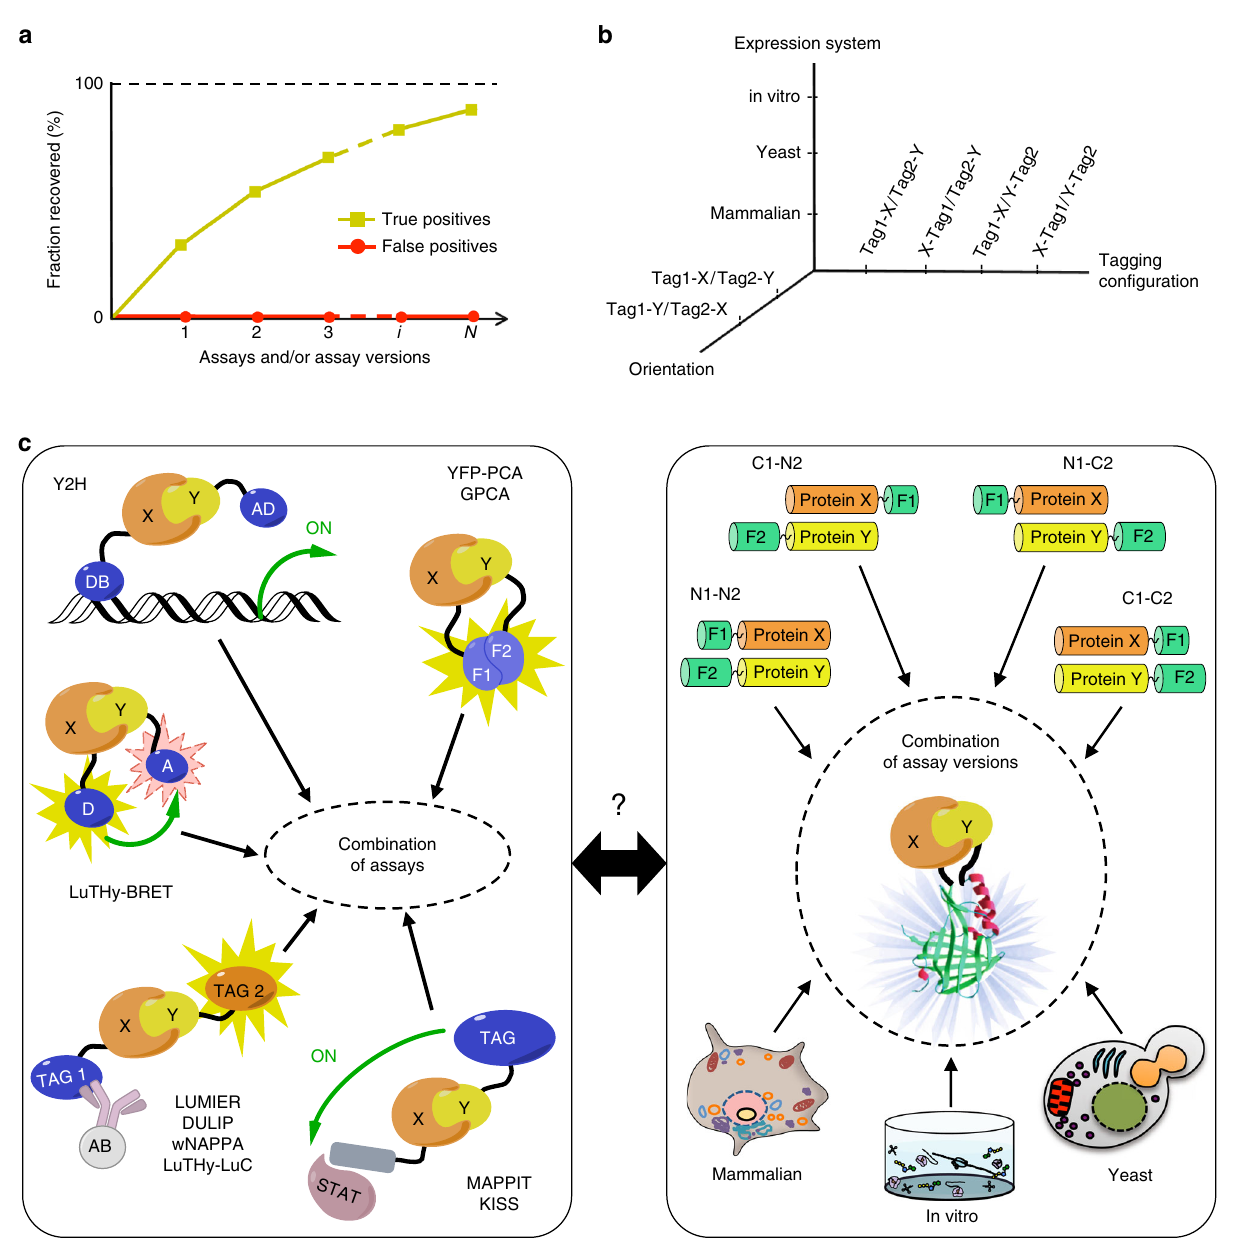
Fig. 1 A framework to combine assays and maximize overall detection. a Combining multiple assays and/or assay versions to increase detection under maximum speci fi city. b A multi-dimensional space of experimental conditions for each binary PPI assay. c Comparing combinations of different, distinct assays (left) to combinations of multiple assay versions explored by the single, highly versatile NanoLuc 2-hybrid (N2H) system